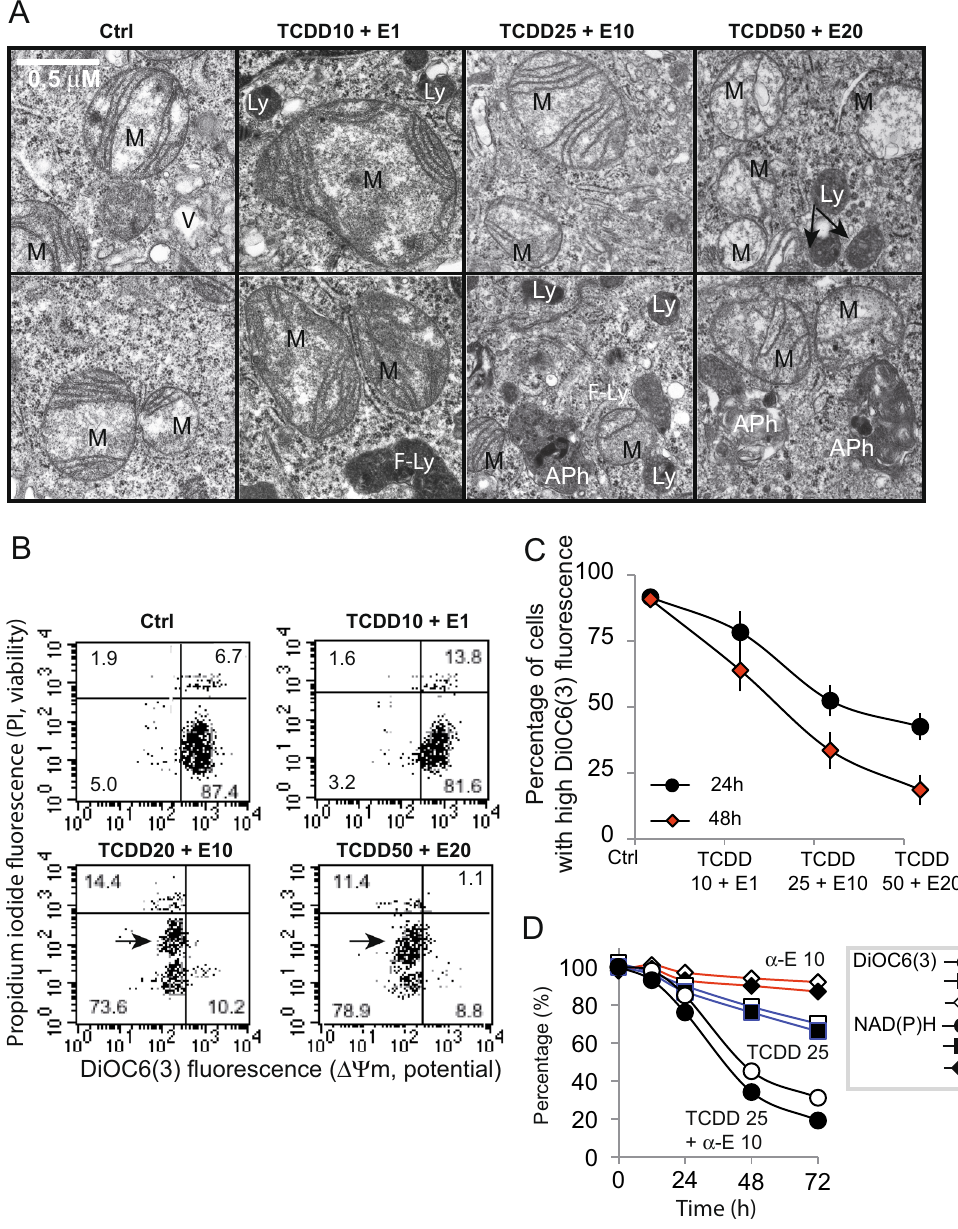
Figure 4. Mitochondria behavior of TCDD + α -E treated cells. ( A ) Electron microscopy pictures of Caco-2 cells treated 48 h with different TCDD + α -E cocktails. Two pictures for each treatment are presented as representative of the subcellular organelles affected by each treatment (top and bottom). M; Mitochondria, Ly; lysosomes, APh; autophagosomes, F-Ly; Fused lysosomes. The bar in the first top left panel represents 0.5 μ M. ( B ) Biparametric flow cytometric analyses of the mitochondrial membrane potential [ ΔΨ m, DiOC 6 (3)] and permeability of the plasma membrane to propidium iodide (PI). The arrow indicates a cell subpopulation (SP) with low ΔΨ m and intermediate staining for PI. ( C ) Evolution of the mitochondrial membrane potential ( ΔΨ m) as measured by DiOC 6 (3) staining of cells treated 24 h or 48 h with different TCDD + α -E cocktail (n- 18). ( D ) Evolution of the mitochondrial membrane potential [ ΔΨ m, DiOC 6 (3)] and of the NAD(P)H cellular content as a function of time for an incubation with a TCDD25 + α -E 10 cocktail, TCDD25 and a-E alone (n = 20, variations are low and not visibles due to the size of the points used for